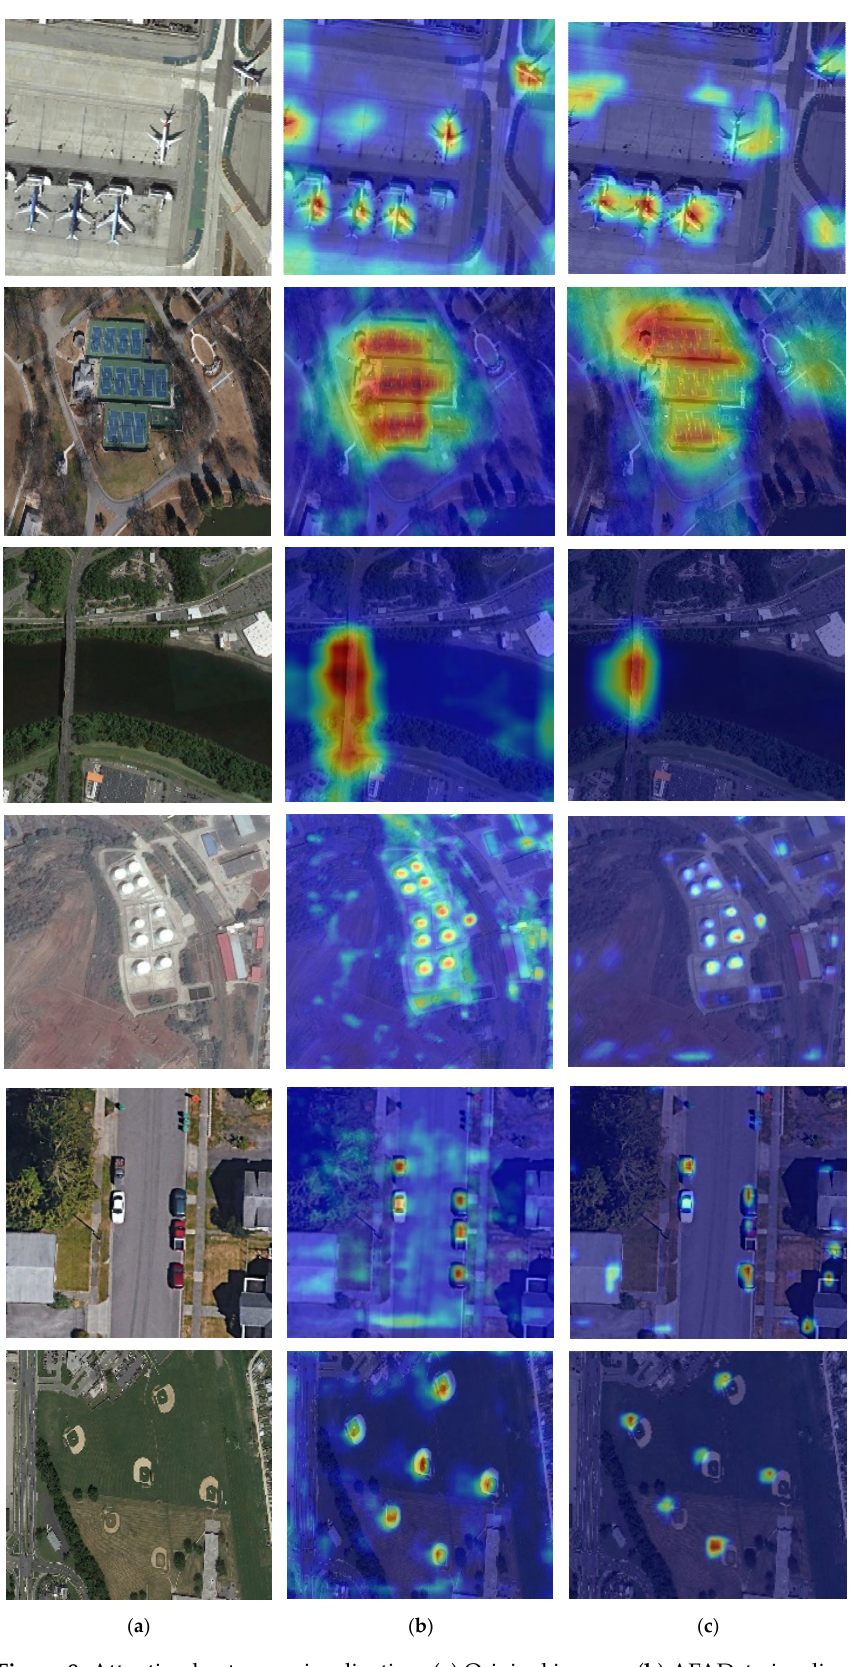
Figure 8. Attention heat map visualization. ( a ) Original images. ( b ) AFADet visualization. ( c ) SSD* visualization.